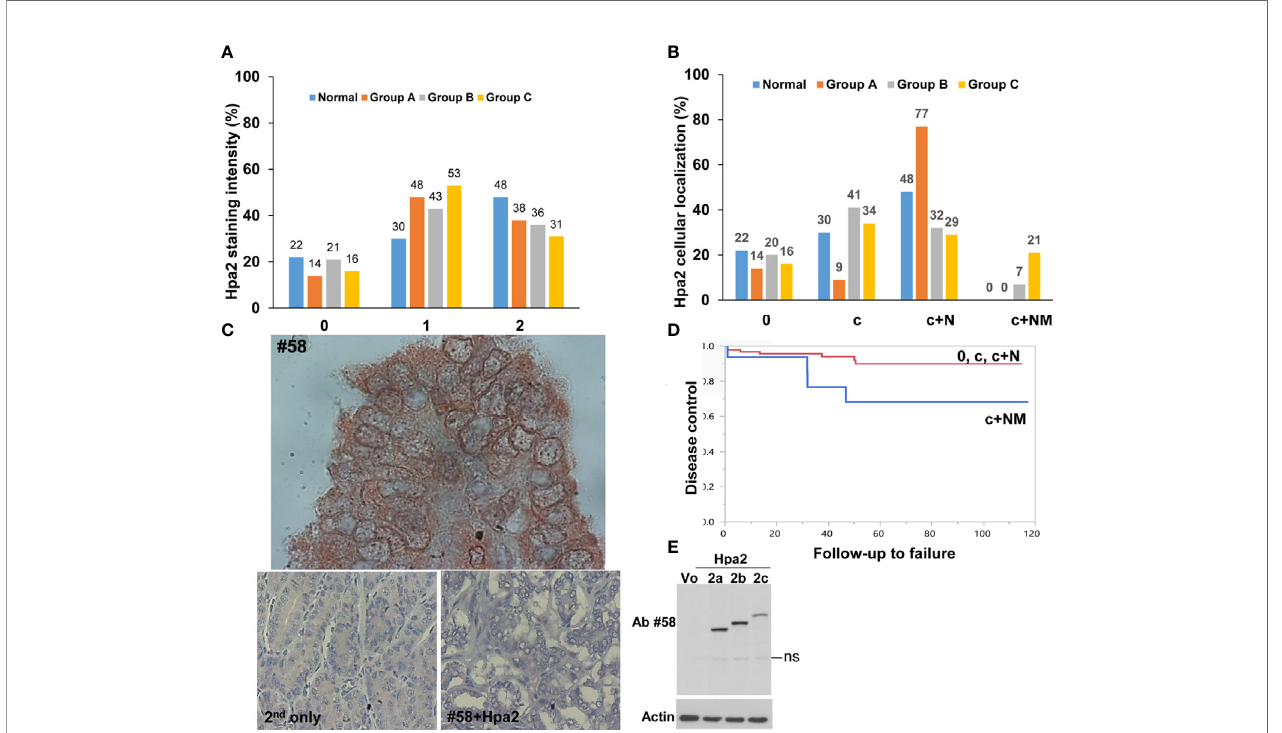
FIGURE 2 | (A) Staining intensity of Hpa2 in the study groups. Hpa2 staining was scored according to its staining intensity (0- negative, 1- weak, 2- strong) in normal, benign (group A), non-metastatic (group B), and metastatic (group C) PTC. Shown is a graphical presentation of the percent of patients in each group according to the staining intensity of Hpa2. (B) Cellular localization of Hpa2. Hpa2 staining was scored according to its cellular localization (c- cytoplasm, c+N- cytoplasm and nucleus, c+NM- cytoplasm and nuclear membrane) in normal, benign (group A), non-metastatic (group B) and metastatic (group C) PTC. Shown is a graphical presentation of the percent of patients in each group according to the cellular localization of Hpa2. Note that NM Hpa2 is much more abundant in metastatic PTC (group C). (C) NM (nuclear membrane) localization of Hpa2. Metastatic PTC was subjected to immunostaining applying anti-Hpa2 antibody. Note, accumulation of Hpa2 immunoreactivity on the membrane of the cell nuclei. No immunostaining is observed once the primary antibody is omitted (lower left panel), or when puri fi ed Hpa2 protein (1 µg/ml) was added together with the primary antibody (#58+Hpa2; lower right panel). Original magni fi cations: upper panel x250, lower panels x100. (D) Plot of locoregional control strati fi ed by cell distribution of Hpa2: c+NM (blue line) vs. other groups 0, c, c+N (red line), p=0.039. (E) Hpa2 splice variants. HEK 293 cells were transfected with control empty vector (Vo) or plasmids that carry the wild type, full-length Hpa2 (2c), or Hpa2 splice variants (2a, 2b) gene constructs. Cell lysate samples were subjected to immunoblotting applying anti-Hpa2 antibody #58 (upper panel) and anti-actin antibody (lower panel). ns- non speci fi c.